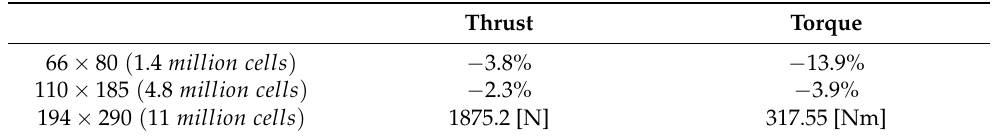
Table 3. Thrust and torque estimation with respect to different blade surface meshes. Reference values correspond to finest grid results.